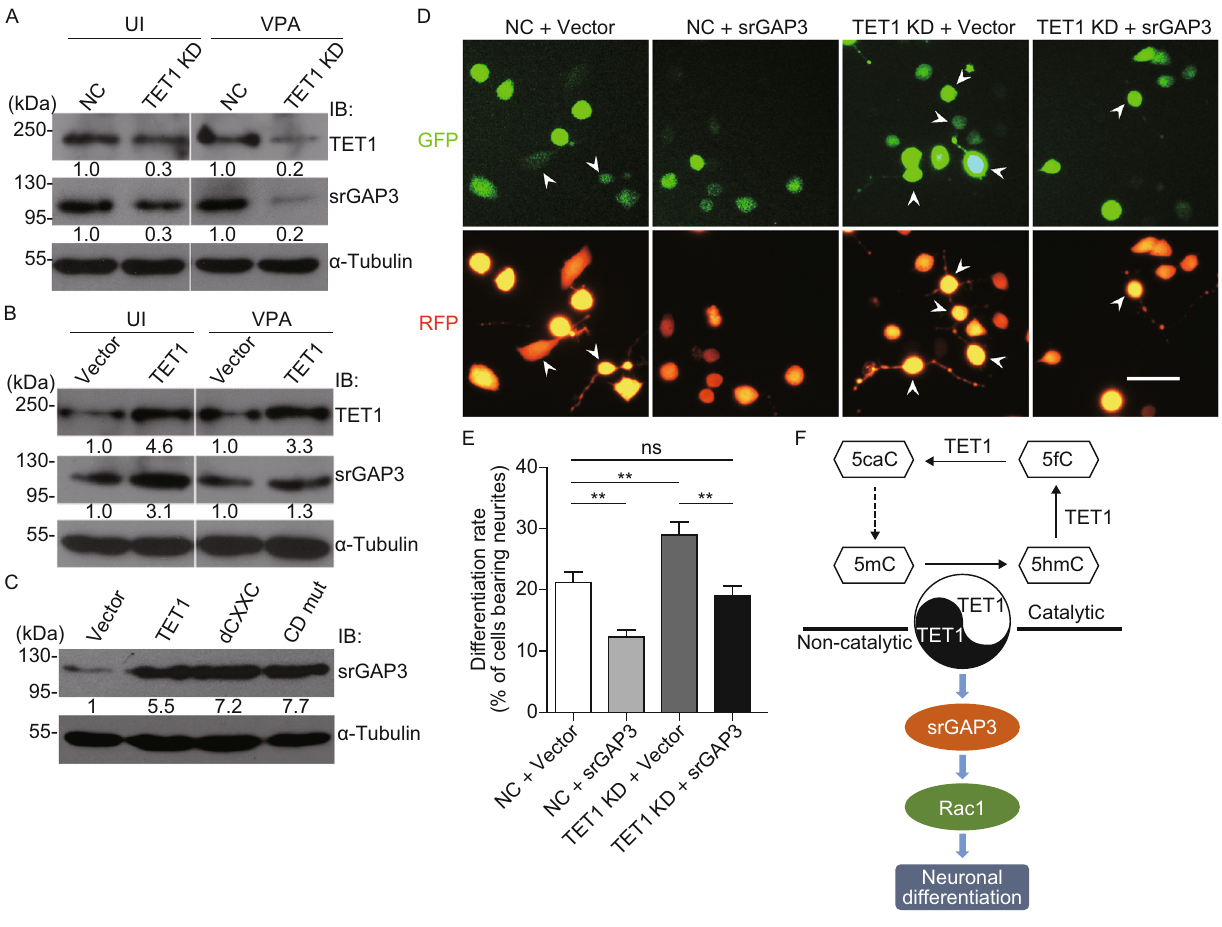
Figure 6. TET1 inhibits neuronal differentiation of Neuro2a cells independent of catalytic activity through srGAP3. (A) Western blotting was used to measure the srGAP3 level after endogenous TET1 knockdown in uninduced Neuro2a cells (UI), and Neuro2a cells after VPA stimulation (VPA) for 24 h. (B) Western blotting was used to measure the srGAP3 level after TET1 overexpression in uninduced Neuro2a cells (UI), and Neuro2a cells after VPA stimulation (VPA) for 24 h. (C) Western blotting was used to analyze srGAP3 level after overexpression of WT TET1 (TET1), TET1 dCXXC (dCXXC), and TET1 CD mut (CD mut). The relative expression level of srGAP3 was calculated by srGAP3/ α -Tubulin. (D) SrGAP3 overexpression constructs or control vector and RFP were co-transfected into the normal or TET1-depleted Neuro2a cells, which were induced by VPA for 24 h. Arrowheads indicate the differentiated cells and arrows indicate undifferentiated cells. Scale bar = 100 μ m. (E) Cell differentiation rate in (C) was analyzed. (F) A proposed working model for TET1 functions in regulating neuronal differentiation. Catalytic activity of TET1 might be suppressed in Neuro2a cells, and non-catalytic activity of TET1 inhibited neuronal differentiation through srGAP3 and Rac1 pathway. Values are mean ± SEM, ** P <